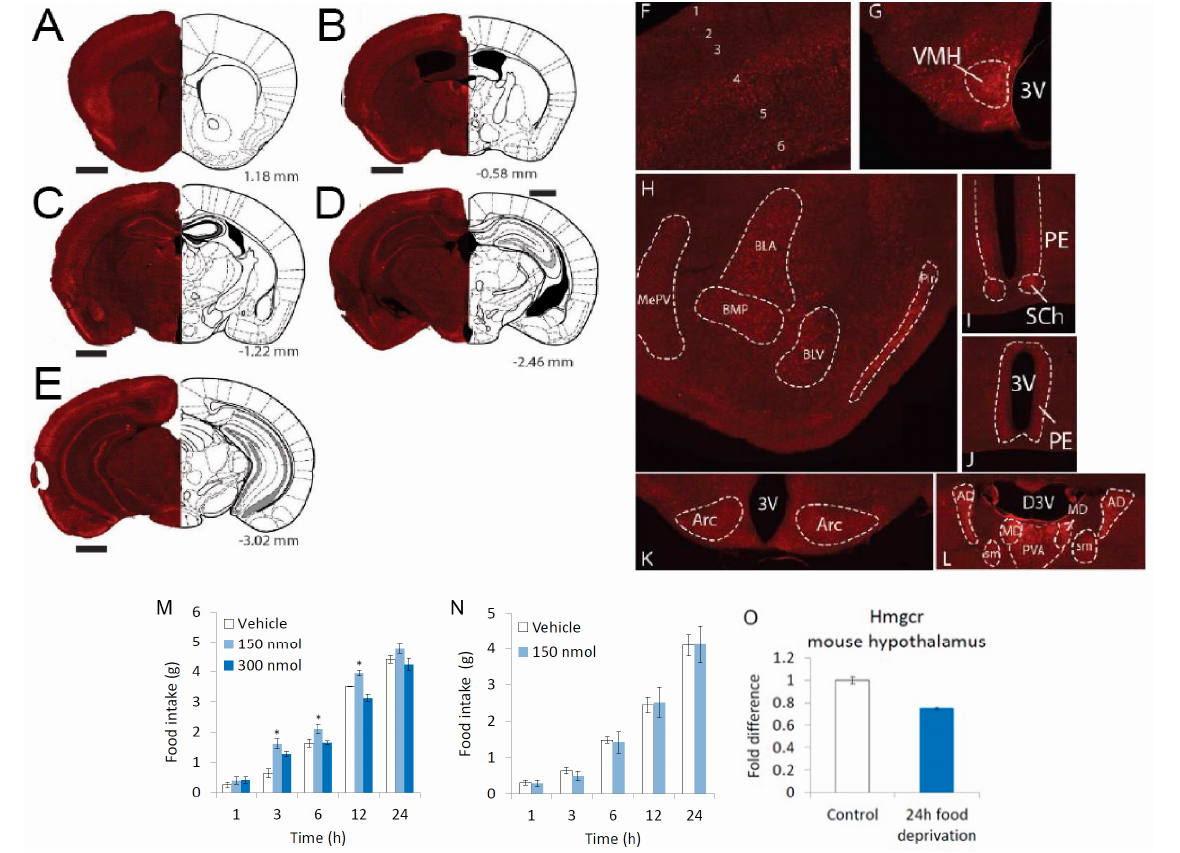
Figure 6. Simvastatin regulates feeding in mice. Expression profile of Hmgcr mRNA using fluorescent floating in situ hybridization on coronal brain sections of adult male C57BL/6 mice visualized as overview and detailed pictures. ( A – E ): Representative pictures of magnified images of the cortex, hippocampus, thalamus, amygdala, and hypothalamus. ( F ) Cortex layers 1–6 (1–6). ( G ) Basolateral amygdaloid nucleus, anterior part (BLA), basolateral amygdaloid nucleus, ventral part (BLV), ba- somedial amygdaloid nucleus, posterior part (BMP), dorsal endopiriform claustrum (DEn), ventral endopiriform claustrum (VEn), medial amygdaloid nucleus, posteroventral part (MePV), ( H ) ventro- medial hypothalamic nucleus (VMH), ( I ) periventricular hypothalamic nucleus (Pe), suprachiasmatic nucleus (SCh), intercalated nuclei of the amygdala ( I ), ( J ) periventricular hypothalamic nucleus (Pe), third ventricle (3V), ( K ) arcuate hypothalamic nucleus, dorsal part (ArcD), arcuate hypothalamic nucleus, lateral part (ArcL) ( L ) anterodorsal thalamic nucleus (AD), nucleus of the stria medullaris (sm), mediodorsal thalamic nucleus (MD), paraventricular thalamic nucleus, anterior part (PVA), dorsal third ventricle (d3v). Bregma levels and described brain regions are according to Franklin and Paxinos 2007 [25] and Allen Mouse Brain Atlas [26]. Black scale bar, 1 mm. ( M ) Various concentrations of simvastatin were injected directly into the hypothalamus of mice, after which, the total amount of food consumed was measured ( n = 10 mice per concentration, one-way ANOVA with Bonferroni post hoc test for multiple comparisons, * p < 0.05). ( N ) Various concentrations of simvastatin were injected peripherally into the peritoneal of mice, after which the total amount of food consumed was measured ( n = 10 mice per concentration, one-way ANOVA with Bonferroni post hoc test for multiple comparisons, * p < 0.05). ( O ) Relative level of Hmgcr transcript in the hypothalamus from starved male mice ( n = 10 qPCR runs; one-way ANOVA with Bonferroni post hoc test for multiple comparisons, * p < 0.05). In all graphs, error bars =